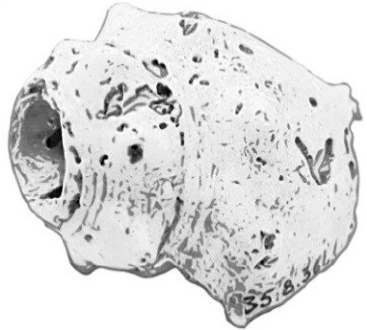
Figure 2. Shell horn made from Aliger gigas , Teotihuacan (EmS, Inv. 35.08.0361); length: 6.1